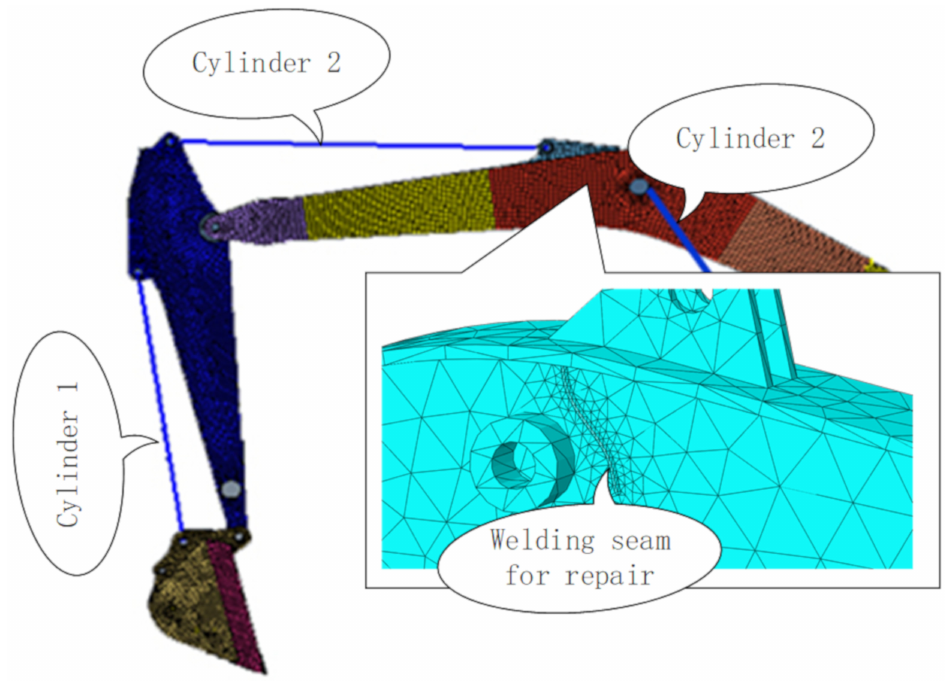
Figure 5. The preprocessing on the FEA model of the excavating